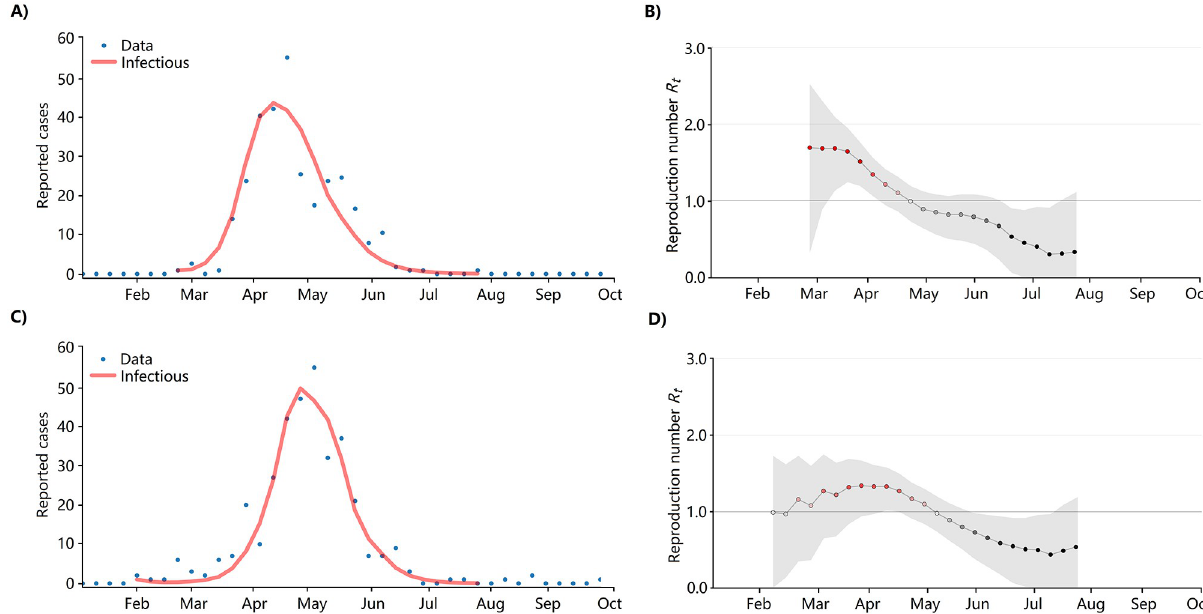
Fig 11. (Top) Reported cases (blue dots) and model prediction (Red). (Below) Values of the transmissibility β vh for Lima (including all districts) outbreaks in 2017 and 2020 (green lines) and the effective reproduction number R